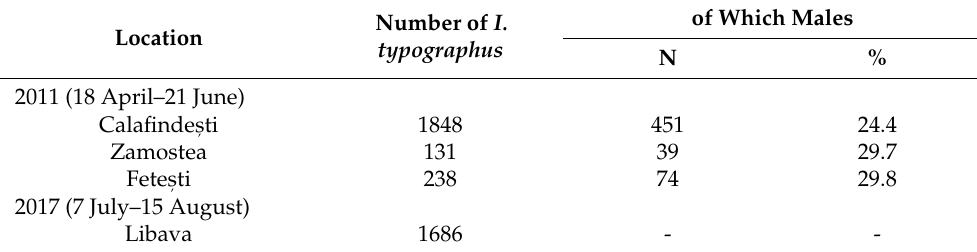
Table 7. Ips typographus beetles caught in the field.